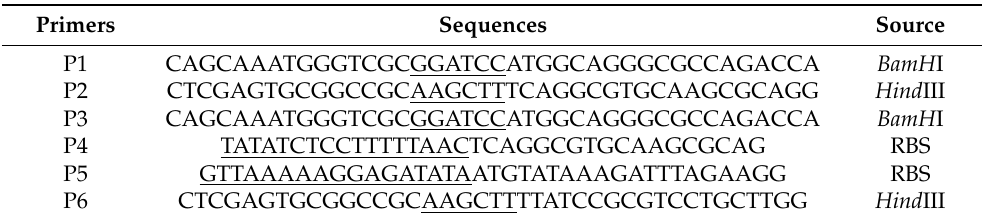
Table 4. The primers used in this